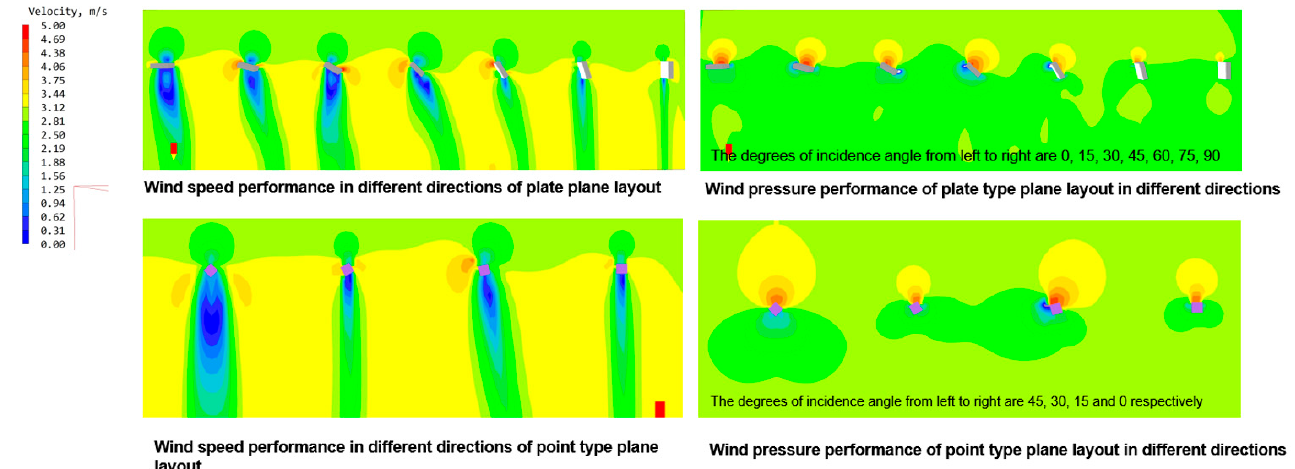
Figure A8. Effect of building orientation on wind